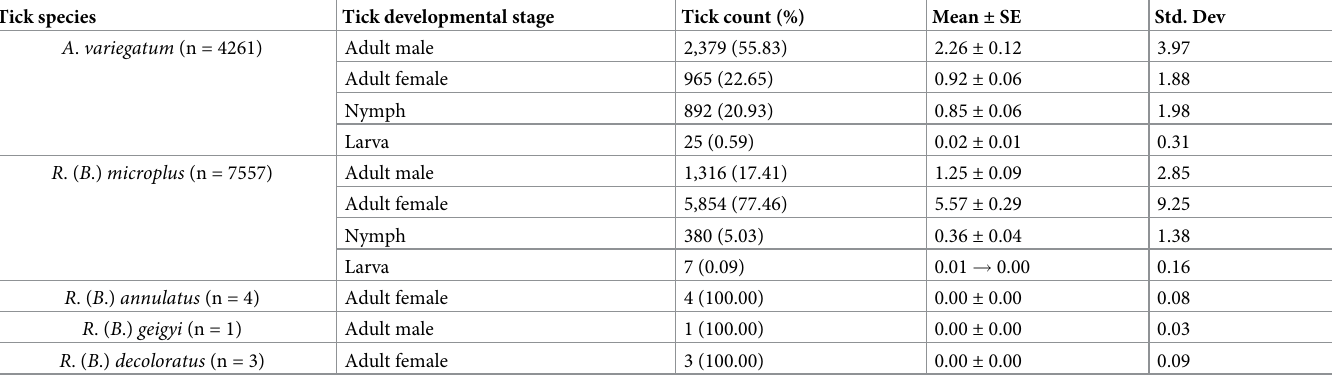
Table 1. Distribution of ticks infesting cattle in Kwara State, Nigeria.